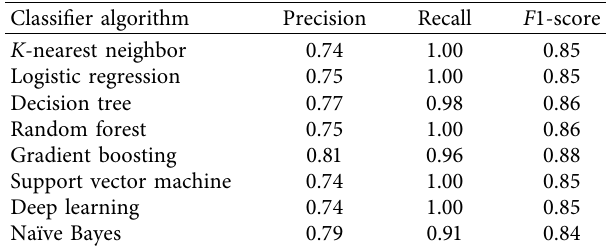
Table 6: Algorithms and performance measure on the classified superior